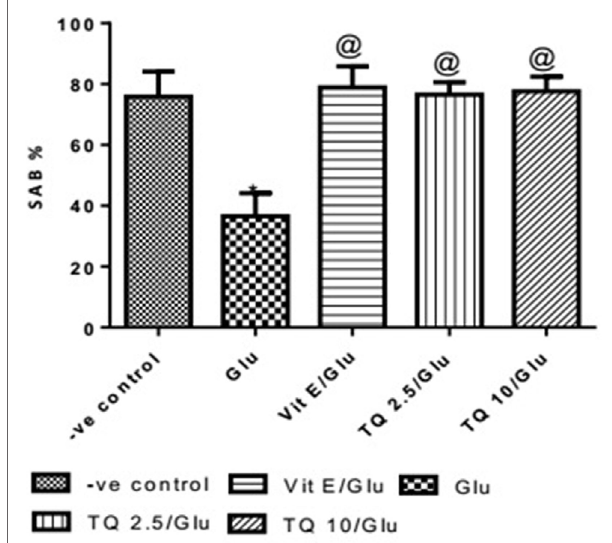
FigUre 5 | Effect of Glu, Vit E/Glu, TQ2.5/Glu, and TQ10/Glu on Cyto-C gene expression. Glu was injected i.p. as a single dose for 7 days. TQ and Vit E were injected as a single dose for 7 days. Each value represents the mean value of 12 rats ± SEM. Statistics were carried out by one-way ANOVA followed by Tukey’s multiple comparison tests, by graph pad prism 5. *statistically significant from − ve control group ( p < 0.05); @